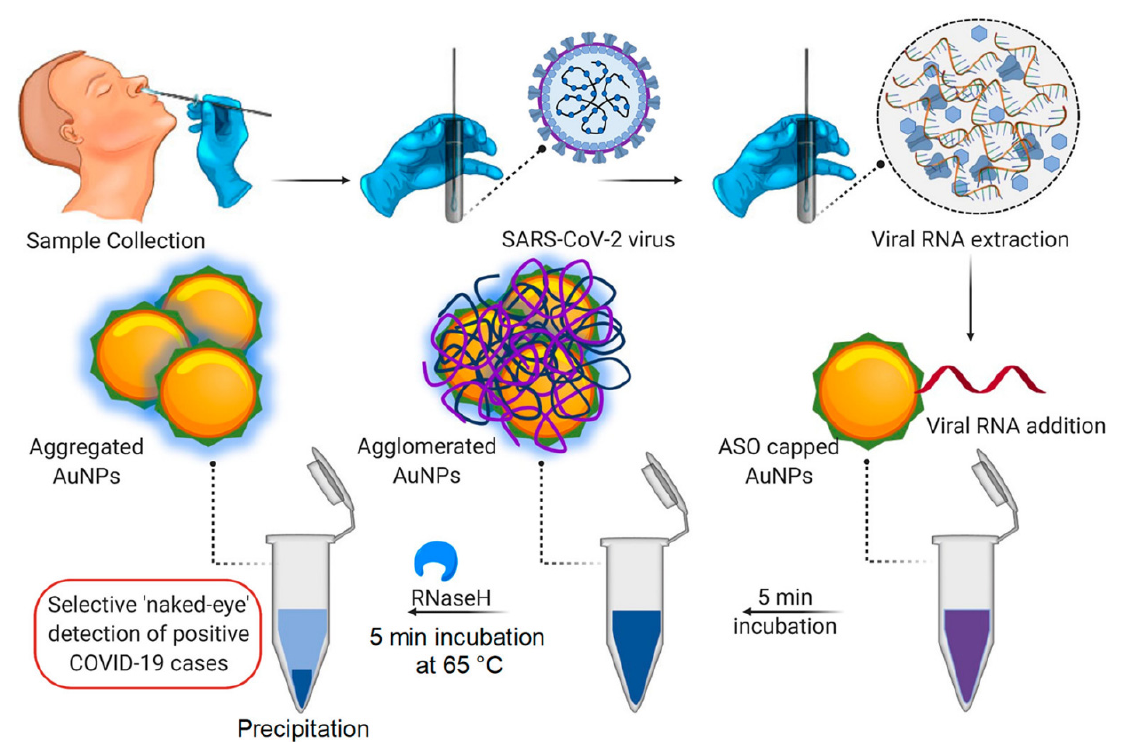
Figure 4. Illustration of Colorimetric assay for SARS-CoV-2 determination through N-gene (repro- duced with permission from Moitra, P. et al., ACS Nano, 2020, 14, 7617–7627 [54]).